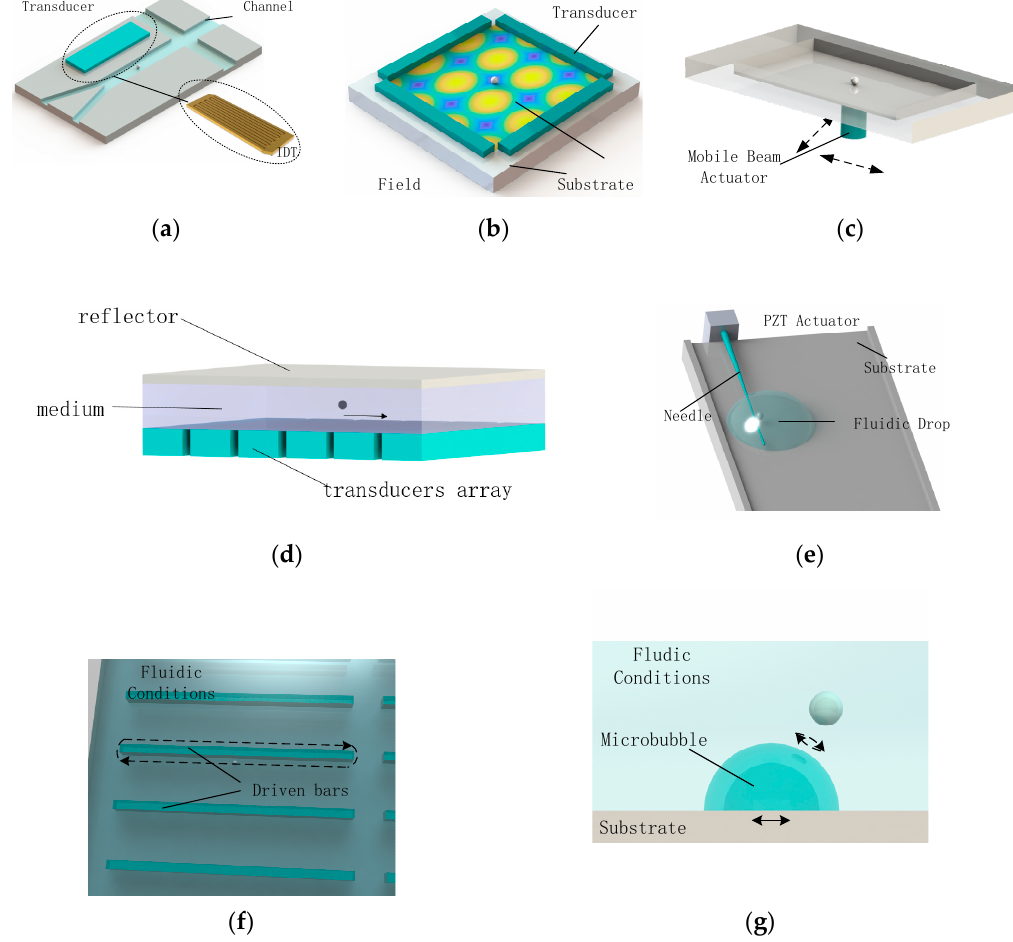
Figure 1. Schematic diagrams of several typical ( a – d ) vibration-induced acoustic wave (VAW) and ( e – g ) vibration-induced streaming flow (VSF)devices (introduced in Section 4): ( a ) cell sorting device based on traveling surface acoustic wave (TSAW) [16], which is a widely used scheme; ( b ) dynamic acoustic field micromanipulation device based on standing surface acoustic wave (SSAW). ( a , b ) Typical SAW devices, which will be introduced in Section 3.1. ( c ) Ultrasonic acoustic beam actuator using bulk acoustic wave (BAW). ( d ) One-dimensional (1D) ultrasonic acoustic transducers array manipulator. ( c , d ) Typical BAW devices, which will be introduced in Section 3.2. ( e ) Vibrated needle manipulation; ( f ) vibrated geometric substrate manipulation systems [10]. ( g ) Manipulation by vibrated microbubble induced microflow.